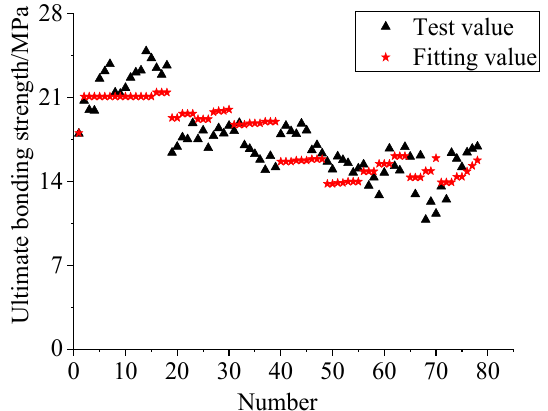
Figure 26. Fitted and experimental values of the ultimate bonding strength.